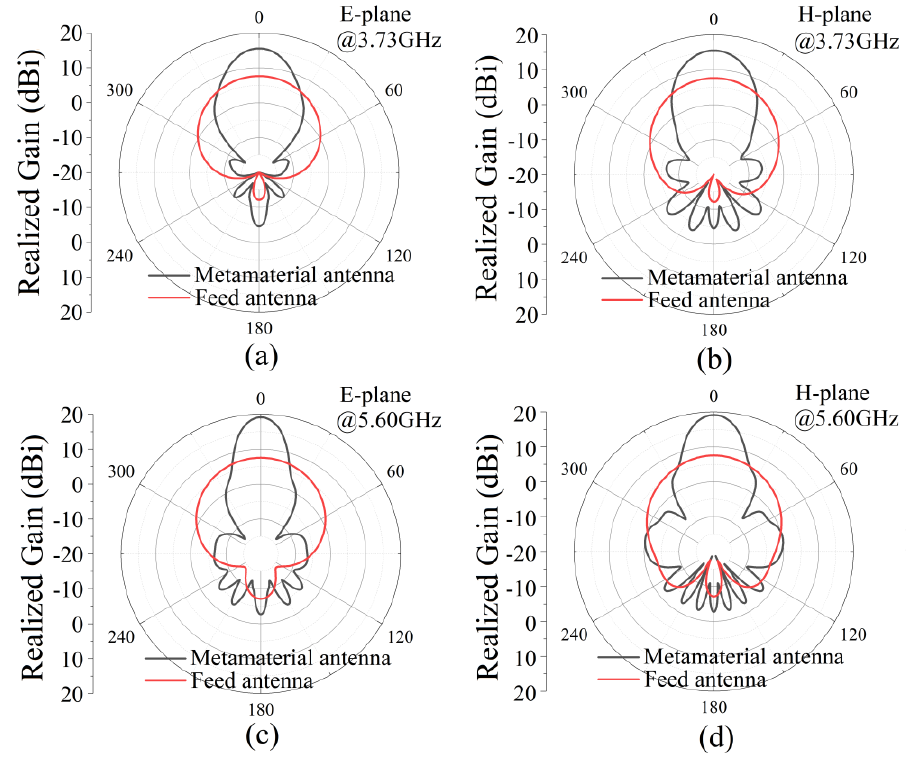
Figure 8. Simulated radiation patterns on ( a , c ) the E-plane and ( b , d ) the H-plane at 3.73 GHz and 5.60 GHz. The black lines are the results for the metamaterial antenna, and the red lines are the results for the feed patch antenna.